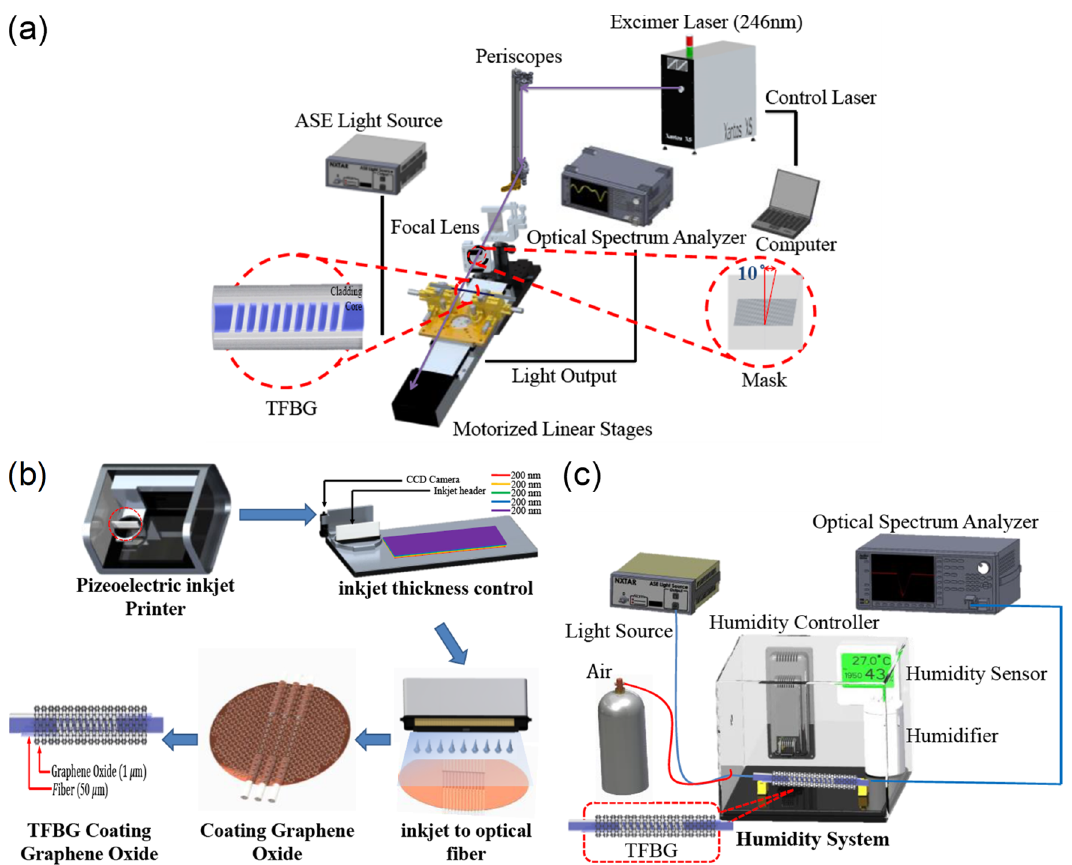
Figure 26. Point sensor. ( a ) Fabrication process of the sensing fiber. ( b ) Fabrication process of the graphene oxide coating . ( c ) Experimental setup. Adapted with permission from ref. [128]. Copyright 2017 MDPI